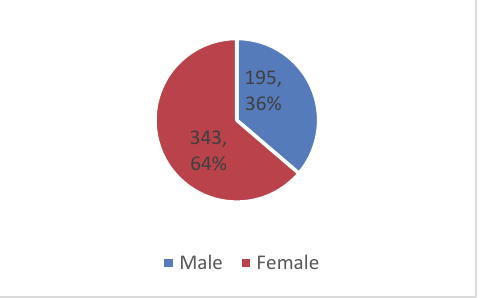
Fig. 2. Gender distribution of participants Fig. 3. Academic performance of the participants